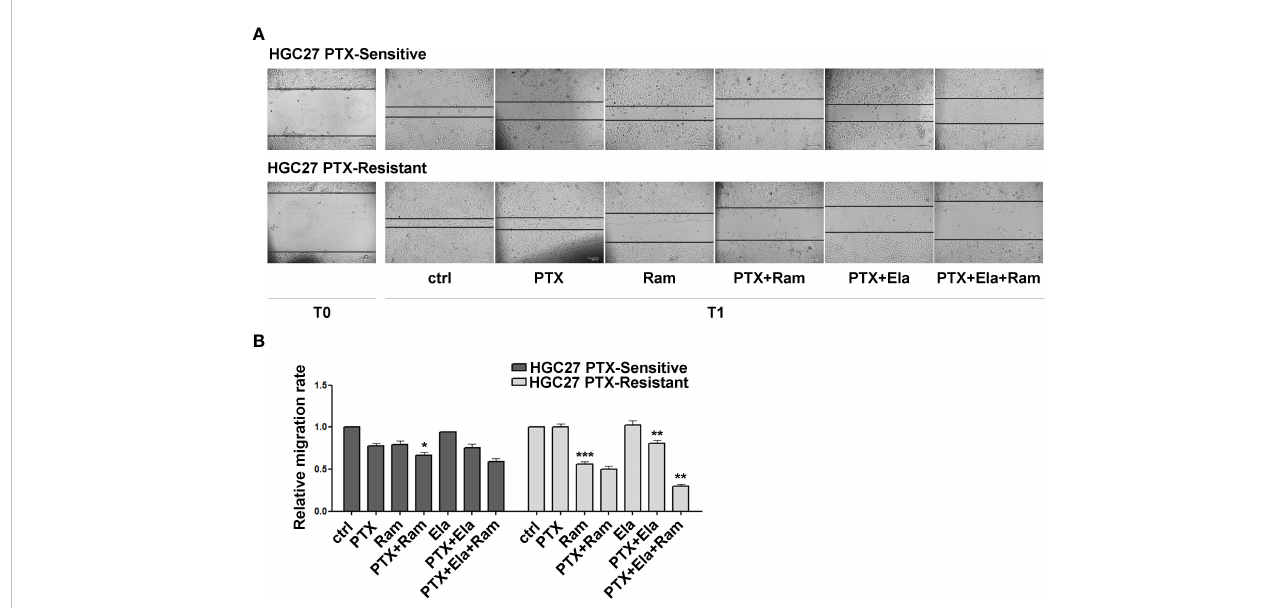
FIGURE 5 The effects of both Ramucirumab and Elacridar on PTX-mediated inhibition of cell migration. (A) scratch assay assessed on HGC27-S and HGC27-R treated with 4 nM PTX, 100 m g/mL Ram and 100 nM Ela alone or in combination. The cells were microscopically analyzed at the time of the scratch (T0) and after 24 hrs (T1); (B) The relative migration rate was calculated by setting the percentage of migration of the control cells at time T1 equal to 1 and comparing the percentage of migration of the cells after each drug treatment to this value. The experiments were performed in triplicate and the mean values ± SD were plotted in the relative graph. Statistical analysis was assessed comparing the values obtained using single drug treatment to those of corresponding untreated cells and the combined treatments to those of the single treatments, *p < 0.05; **p < 0.01; ***p <